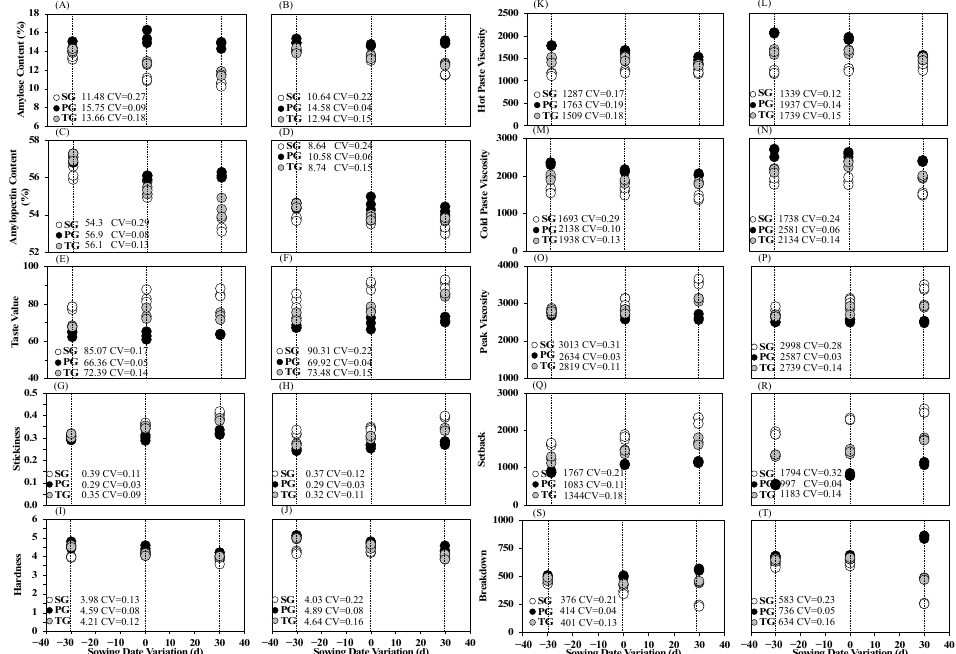
Figure 4. Cooking and taste quality parameters and RVA characteristics of grains located on different positions and sowing dates of N7 ( A – J ) and N9108 ( K – T ). Note : White dots represents grains located on secondary branches (SG); Black dots represents grains located on primary branches (PG); Grey dots represents total grains (TG). CV represents covariance of 3 biological replicates. N7 and N9108 represents Nanjing 7 and Nanjing 9108, respectively.